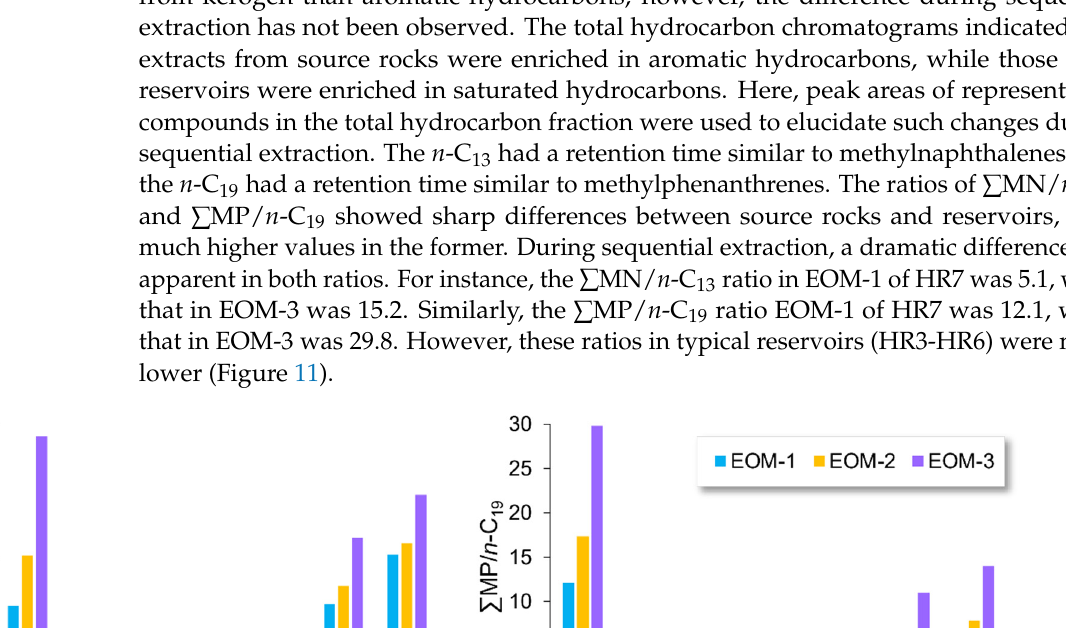
Figure 10. The ratio of ∑ C 0–5 –alkylnaphthalenes/ ∑ C 0–3 –alkylphenanthrenes ( ∑ C0–5N/ ∑ C0–3P) in sequential extracts of the studied samples.